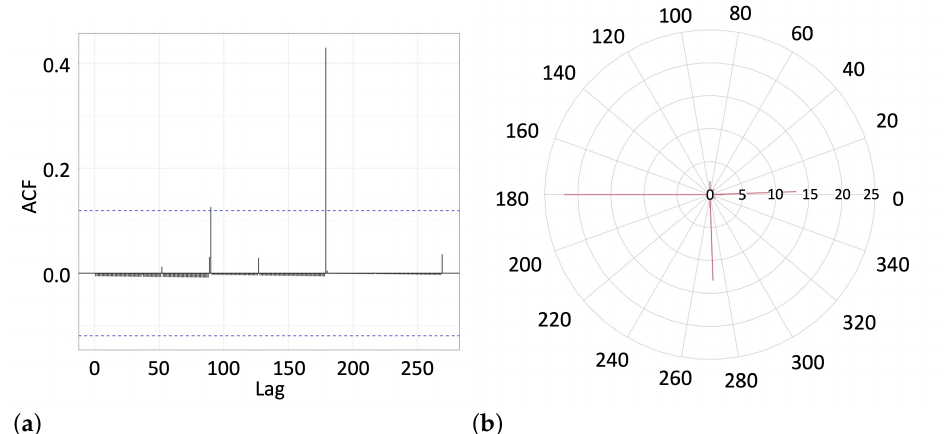
Figure 6. ( a ) The autocorrelation function (10) represents a single statistically significant lag (of 180 ◦ ) between the sequentially drawn lines in Group 2. The dashed horizontal line indicates the level of statistically significant correlations. ( b ) The radial histogram (not normalized) of the line-drawing angles observed in Group 2.